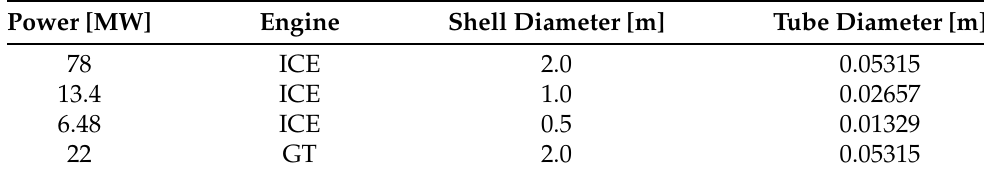
Figure 9. A diagram of a counterflow shell and tube heat exchanger (HX). Table 6. Shell and tube diameters for the waste heat recovery (WHR) device based on effective output power